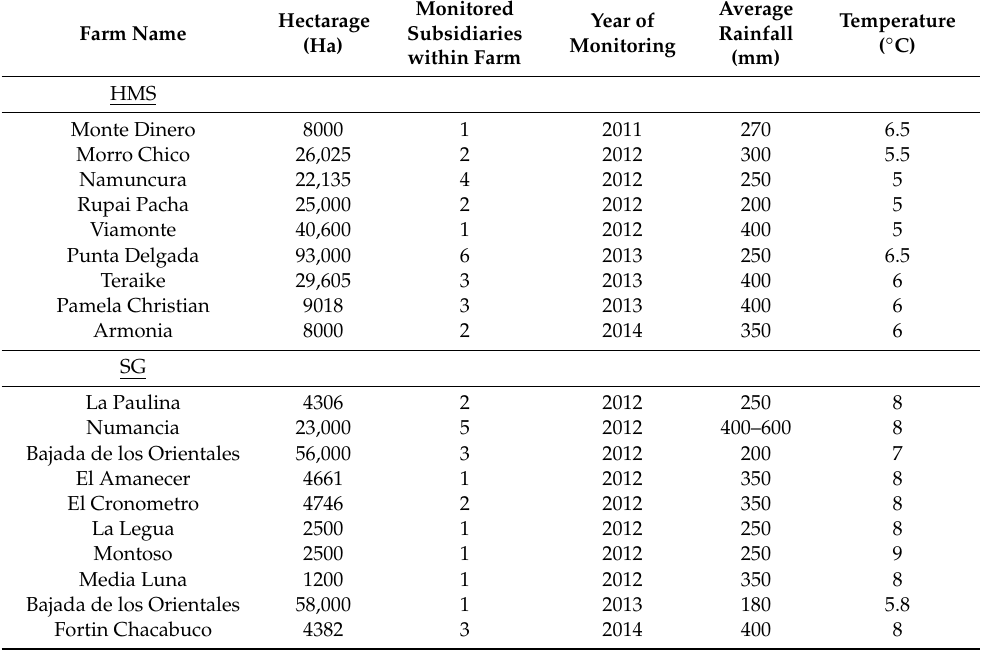
Table 1. Climate and monitoring information of the Humid Magellan Steppe (HMS) and Subandean Grasslands (SG)